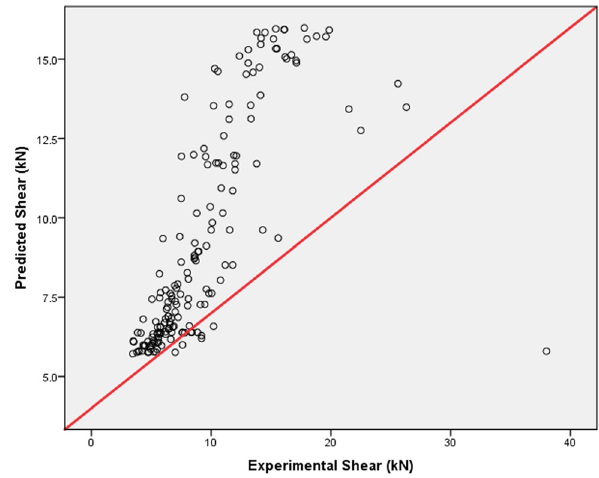
Figure 6: Comparison of shear force strength between experimental and predicted